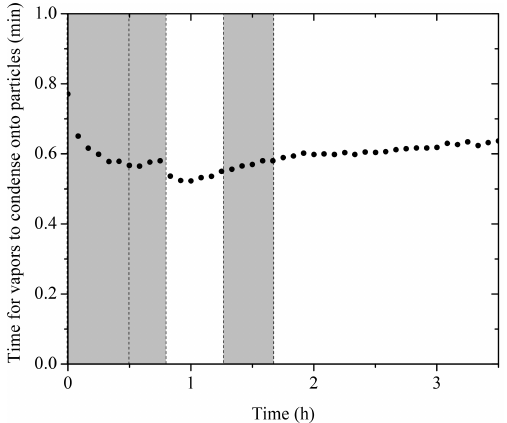
Figure 9. The calculated condensation sink (CS) in the form of timescale for vapors condensing onto particles (1 / CS). Ozone was added into the chamber at time zero to initiate α -pinene ozonolysis. The shaded areas indicate that the chamber was dark. The dashed lines mark the beginning and the end of the two times HONO were